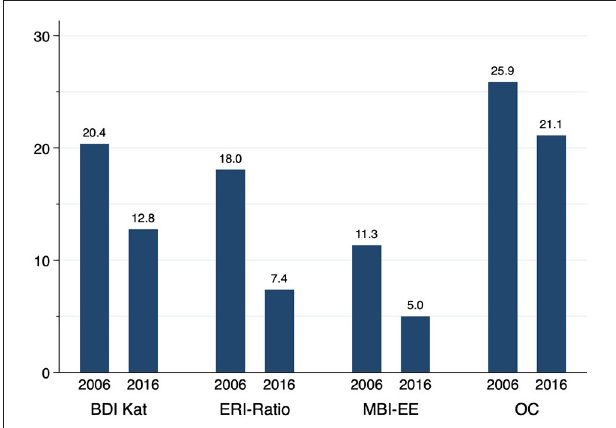
FIGURE 1 | Percentage of surveyed psychiatrists 2006 and 2016 scoring high in the areas of clinically relevant depression (BDI > 10, BDI-II > 13), acute burnout risk (MBI-EE > 4.5), effort-reward-imbalance (ERI > 1), and overcommitment (OC > 16).